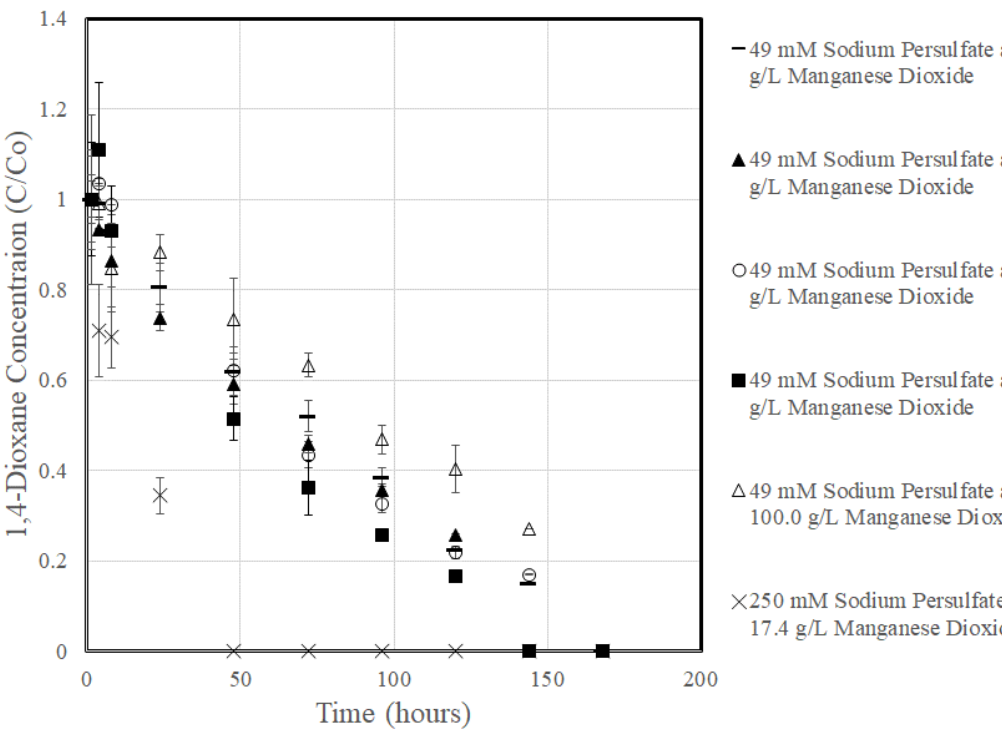
Figure 4. Relative concentration as a function of time illustrating removal kinetics of 1,4-D using PS with various MnO 2 amendment amounts. Relative concentrations were normalized by the initial 0.5 mM of 1,4-D. Error bars represent the standard deviation of triplicate samples.